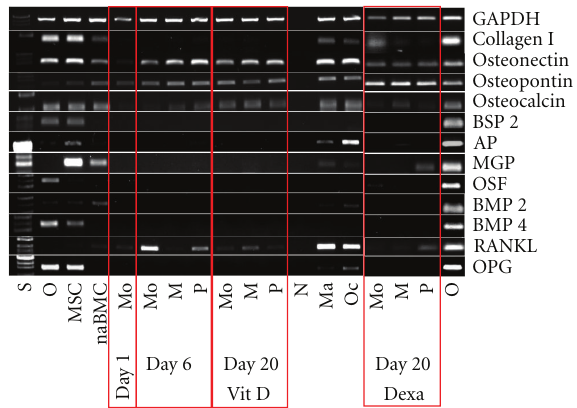
Figure 4: Di ff erentiation treatment did not change bone marker expression. Expression pattern on important osteoblast marker gens detected by RT-PCR. Freshly isolated monocytes (Mo); M and P after treatment to obtain MOMPs and PCMOs and untreated control cells (Mo, M, P “day 6”), after di ff erentiation with medium containing vitamin D (Mo, M, P “day 20 Vit. D”), or with medium containing dexamethasone (Mo, M, P “day 20 Dexa”); controls: macrophages (Ma), osteoclasts (Oc), primary osteoblasts (O), mesenchymal stem cells (MSC), nonadherent bone marrow cells (naBMC), and negative control (N). ( N = 3, n =